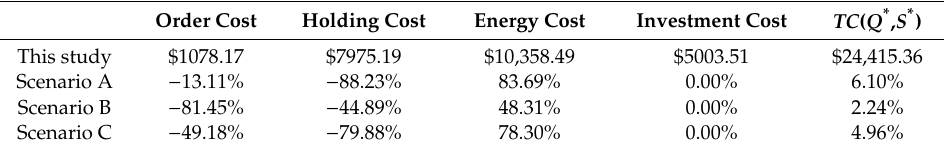
Table 3. Variations in the cost components when compared to those produced by the model proposed in this study.